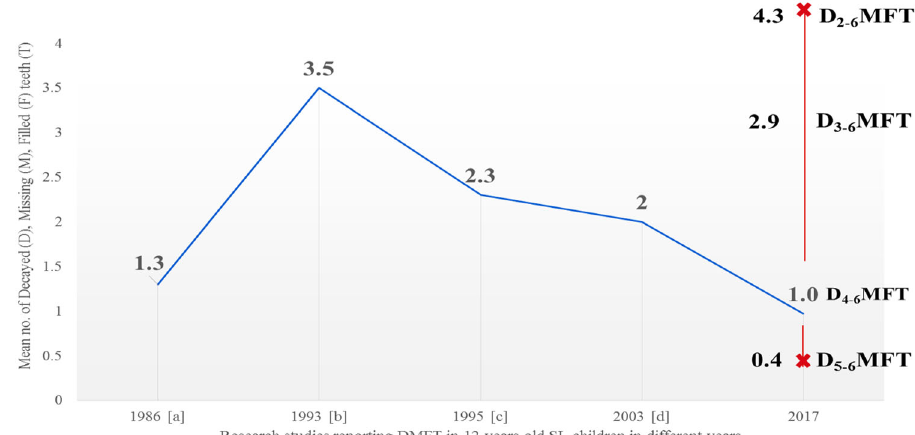
Fig. 1 Trend of dental caries experience (DMFT) in 12-year-olds in SL from 1986 to 2017. a Woodward and Walker [41] (1994). b Nörmark [12] (1993). c Bly and Bradnock [44] (1995). d Don-Davis [14] (2003). 2017 = fi ndings from the current